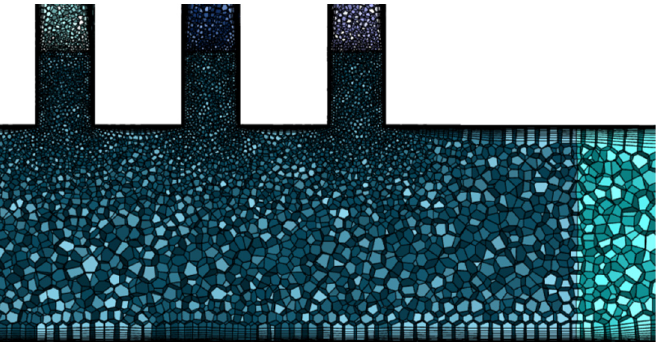
Figure 6. Example of a mesh with variable density (mesh arrangement “03”) at the entrance of a distributor. Extra inlet and outlet volumes were added to the dividing systems to avoid computational issues due to reversed flow (i.e., a light blue mesh visible on this figure’s far-right belongs to an inlet zone).